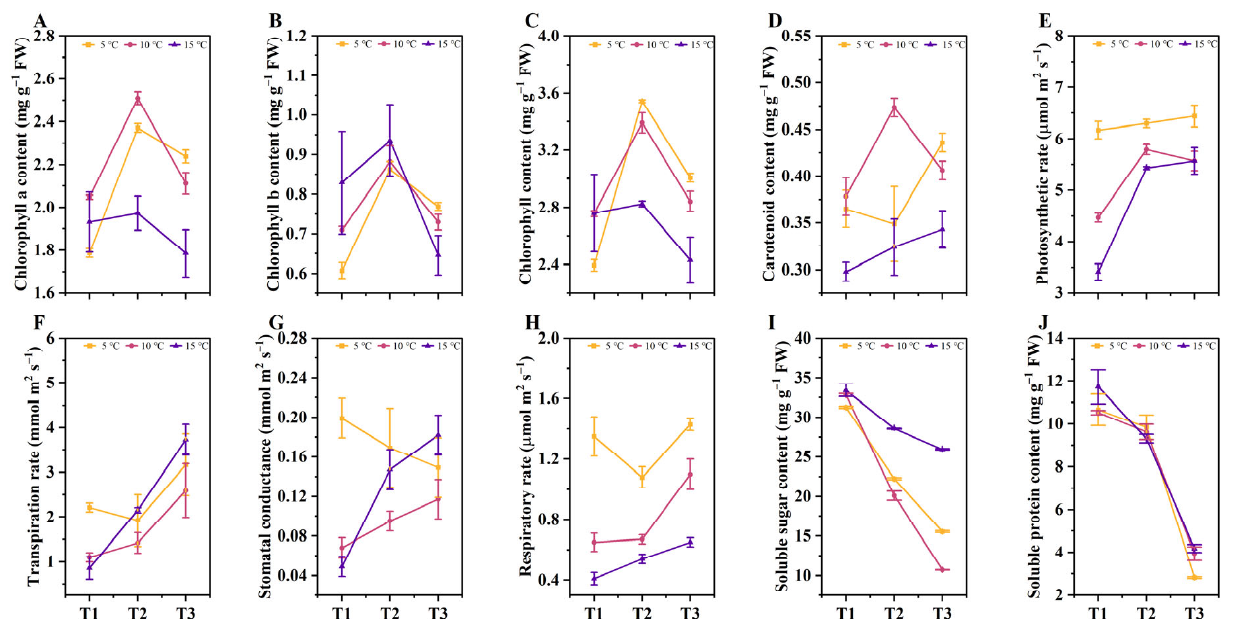
Figure 2. The effects of different DIFs on the photosynthetic indicators, soluble sugars, and proteins. ( A ) Chlorophyll-a content; ( B ) Chlorophyll-b content; ( C ) Total chlorophyll content; ( D ) Carotenoid content; ( E ) Net photosynthetic rate; ( F ) Transpiration rate; ( G ) Stomatal conductance; ( H ) Respiratory rate; ( I ) Soluble sugars; ( J ) Soluble proteins.